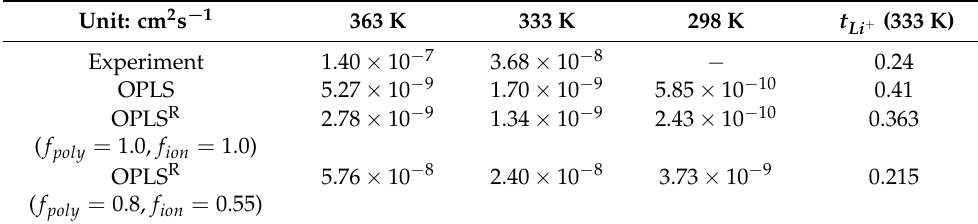
Table 2. Diffusion coefficient for Li + , and lithium transference number (t Li ) for PEO/LiTFSI SPE system in OPLS, full-charged OPLS R and charge-rescaled OPLS R force fields compared with exper- imental data. The reported experimental values were measured for the PEO/LiTFSI SPE systems with O/Li + ratio of 18 at 333 K (data from [11]) and 16.7 at 363K (data from [62]). Unit: cm 2 s − 1 363 K 333 K 298 K t Li + (333 K) Experiment 1.40 × 10 − 7 OPLS OPLS R ( f poly = 1.0, f ion = 1.0)